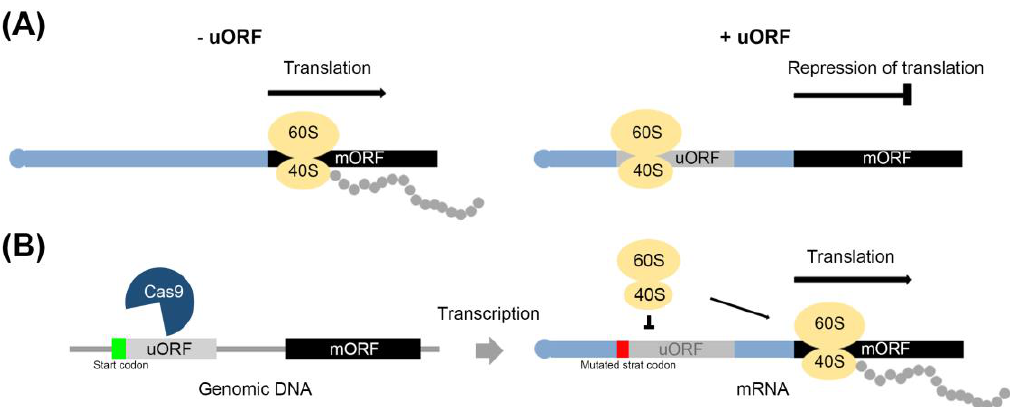
Figure 1. Overview of CRISPR-Cas9-mediated regulation of the repression of translation, as discussed in this review. ( A ) The mRNA (black rectangle) with uORF (gray rectangle) induces ribosome (yellow ovals) stalling in the uORF, which represses translation of the main ORF (mORF). Polypeptide: gray circle. ( B ) Mutation of the start codon region (green or red rectangle) in uORF using CRISPR-Cas9 inhibits ribosome stalling, leading to induced translation of mORF.